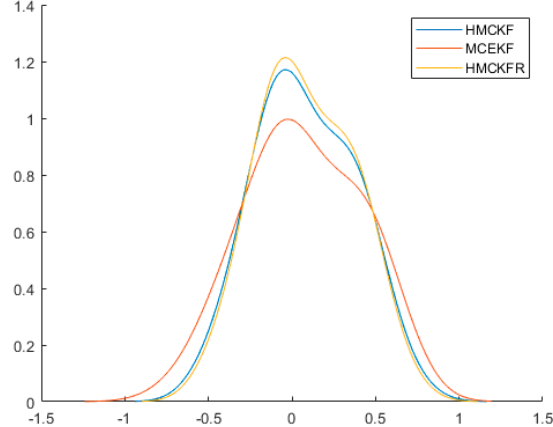
Figure 5. Probability densities of x 2 estimation errors with the three filters in case 1.